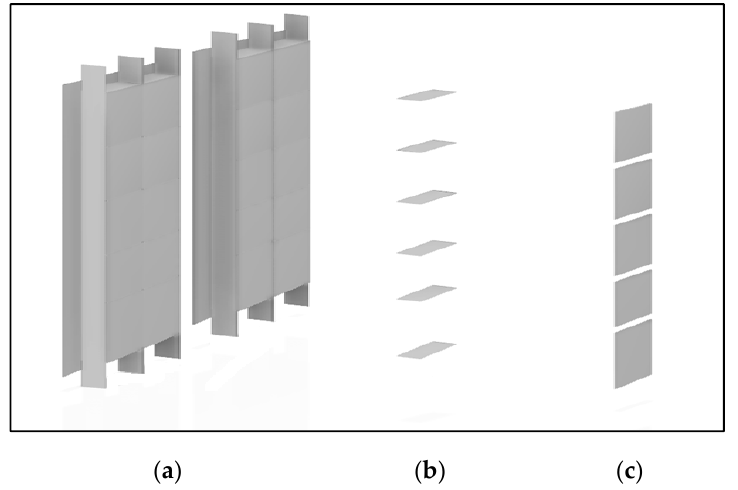
Figure 19. Joining between 2.4 m basic modules: ( a ) 2.4 m panels; ( b ) horizontal stiffening; ( c ) external panels.